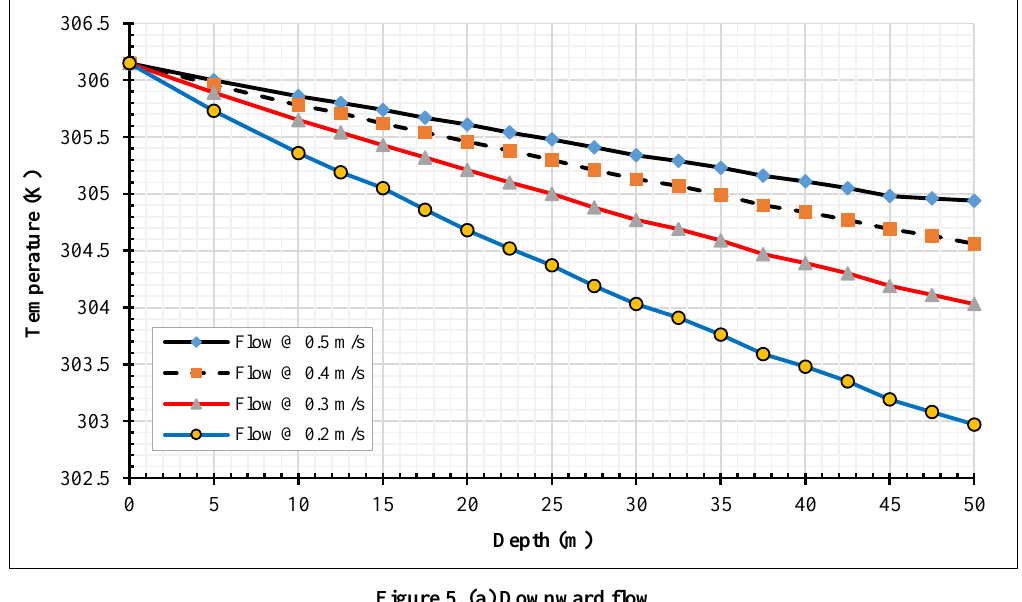
Figure 5. (a) Downward flow